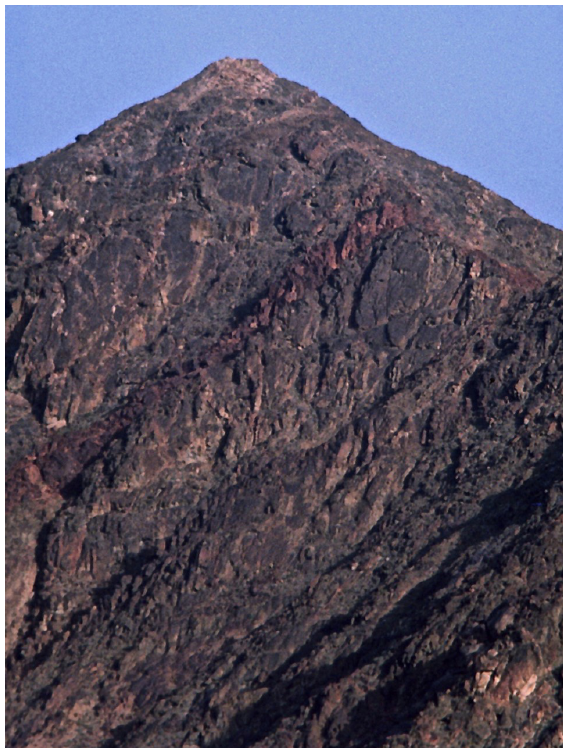
Figure 18 Jebel Moneijah, view from the Feiran Oasis.